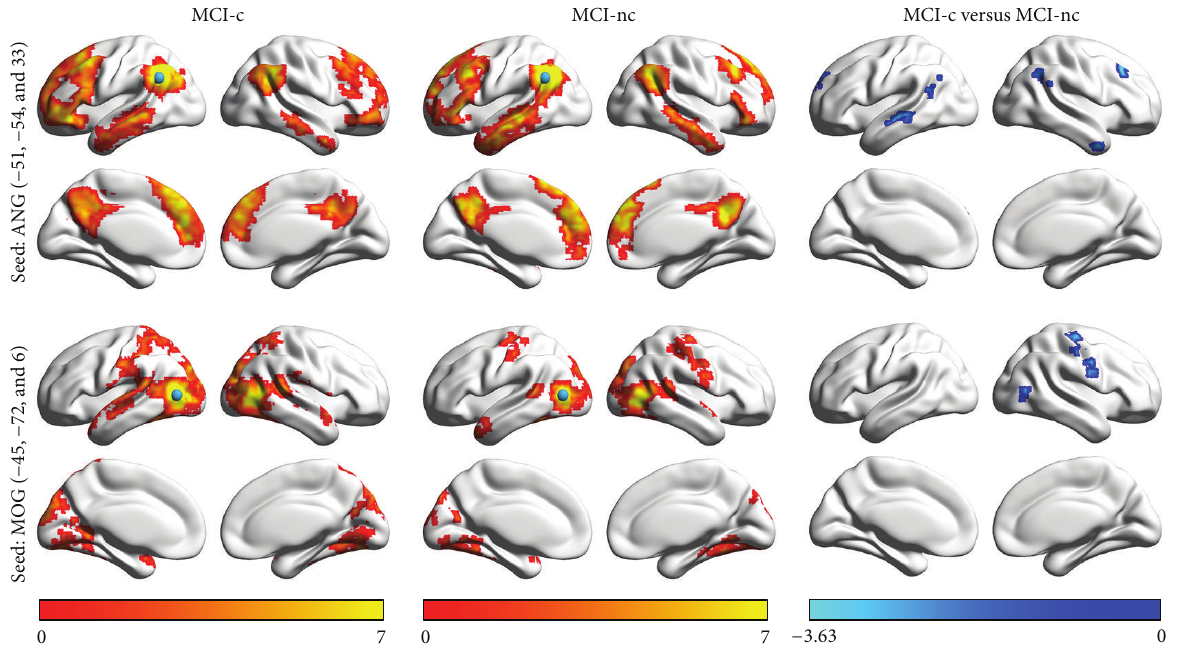
Figure 3: The seed-based RSFC analysis between MCI-c and MCI-nc. The left and middle column present the within group RSFC pattern for the left angular gyrus and the left middle occipital gyrus. Between-group comparison on the right column revealed that comparing to MCI-nc group the MCI-c group had significantly decreased functional connectivity between the left angular gyrus and bilateral dlPFC and lateral temporal cortices and between the left middle occipital gyrus and right central sulci and right middle occipital gyrus. The color bars at the bottom represent the 𝑇 value for either the one-sample 𝑡 -test or two-sample 𝑡